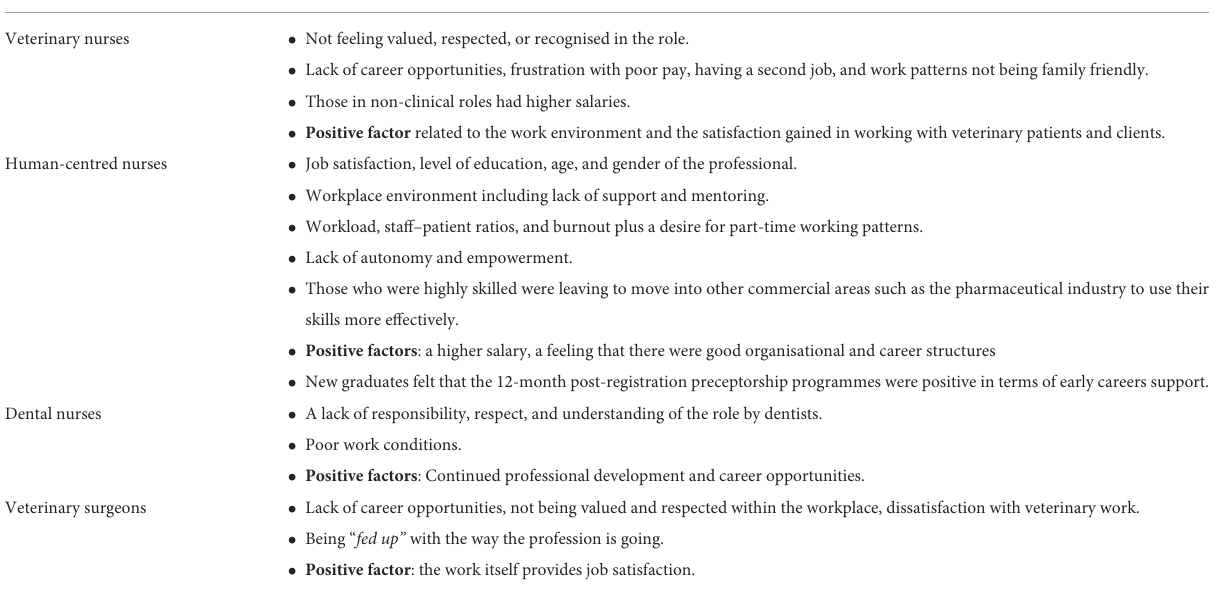
TABLE 1 Summary of factors influencing retention rates within veterinary, human-centred, and dental nursing. Professional group Factors influencing retention